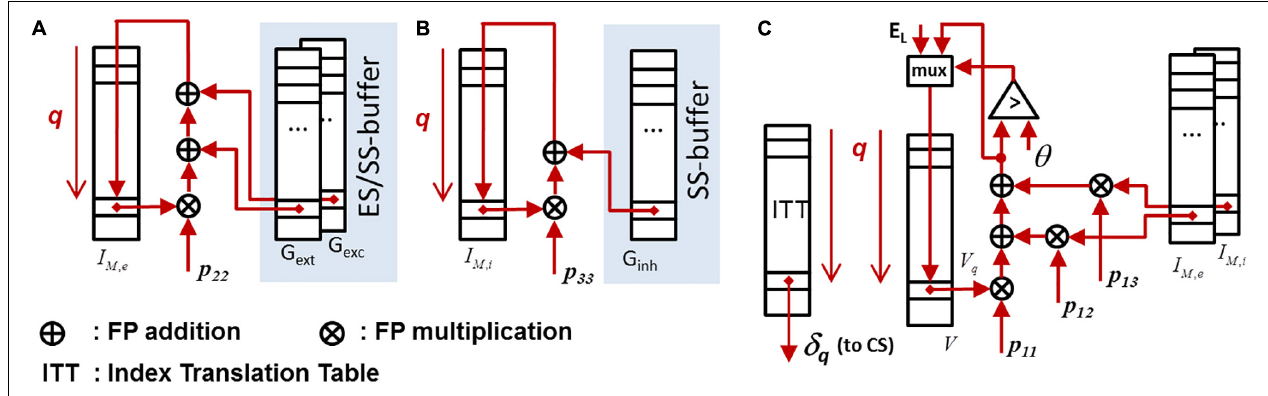
FIGURE 7 | Data paths for exact ODE-integration. The underlying system matrix P = {p ij } representing the ODE-system (1) and (2) has a upper-triangular structure. The state memory is represented by I M , e , I M , i , and V , cf. (1) and (2). Detected spikes are first blocked in the output FIFO and are subsequently released when the router unit is able the process the next spike. (A) Data path for updating the lumped excitatory synaptic input. (B) Data path for updating the lumped inhibitory synaptic input. (C) Data path for updating the membrane